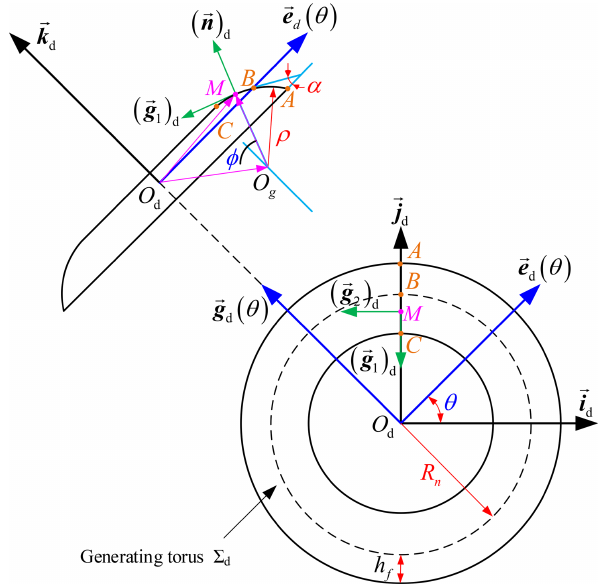
Figure 2. Generating torus of the grinding wheel in σ d